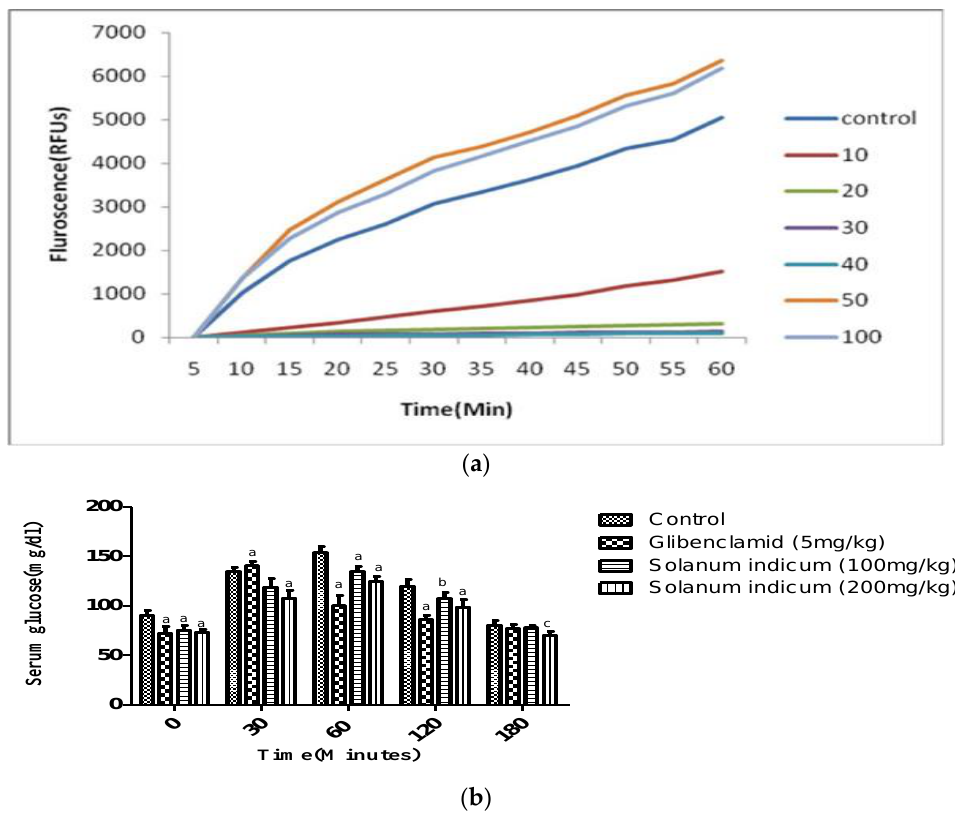
Figure 4. ( a ) Cellular antioxidant activity of the methanolic extract of Solanum indicum fruits; ( b ) Oral glucose tolerance test of the extract of Solanum indicum fruits. All the values were expressed in Mean ± SEM, where, a ( p < 0.001), b ( p < 0.01) and c ( p < 0.05) when compared with the vehicle control animals.